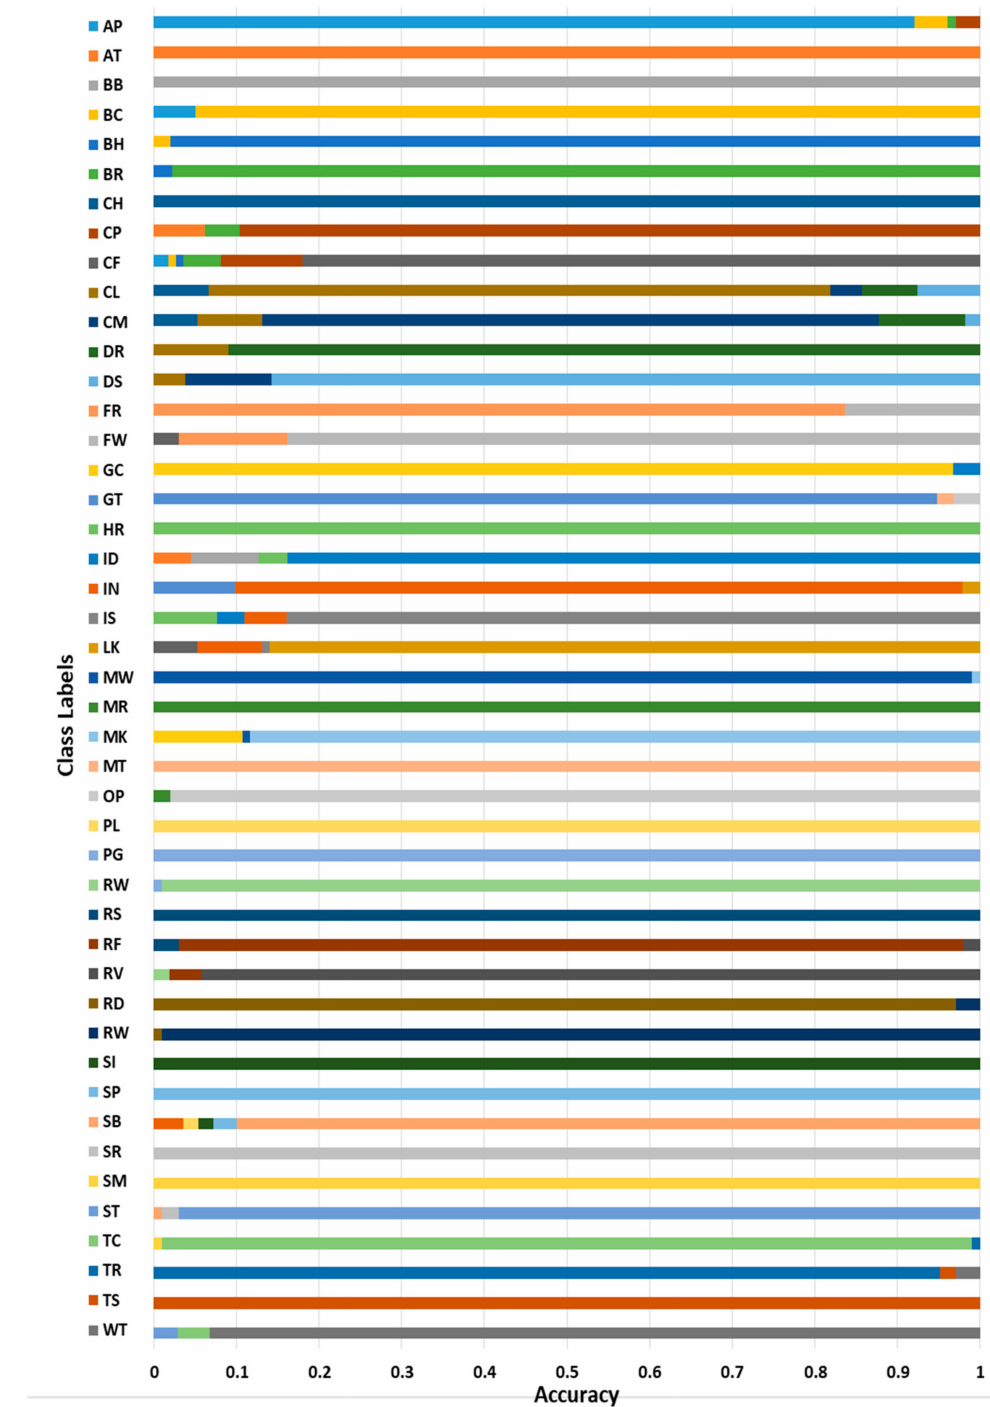
Figure 15. The recognition accuracy of OCSC model over RESISC45 dataset. AP = airplane; AT = air- port; BB = baseball diamond; BC = basketball court; BH = beach; BR = bridge; CH = church; CP = chaparral; CF = circular formland; CL = cloud; CM = commercial area; DR = dense residential; DS = desert; FR = forest; FW = freeway; GC = golf course; GT = ground track field; HR = harbor; ID = island; IN = industrial area; IS = intersection; LK = lake; MW = meadow; MR = medium residential; MK = mobile home park; MT = mountain; OP = overpass; PL = palace; PG = parking lot; RW = railway; RS = railway station; RF = rectangular formland; RV = river; RD = roundabout; RW = runway; SI = sea ice; SP = ship; SB = snow berg; SR = sparse residential; SM = stadium; ST = storage tank; TC = tennis court; TR = terrace; TS = thermal power station; WT =